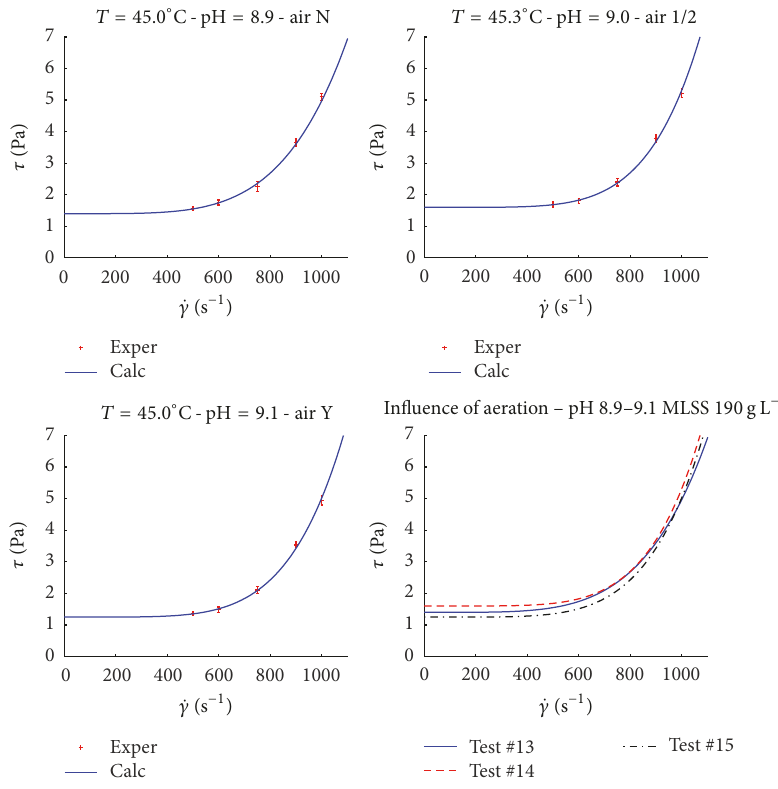
(c) Shear stress versus rate of deformation (MLSS 190gL −1 ). Lower right-hand panel compares calculated values for pH condition around